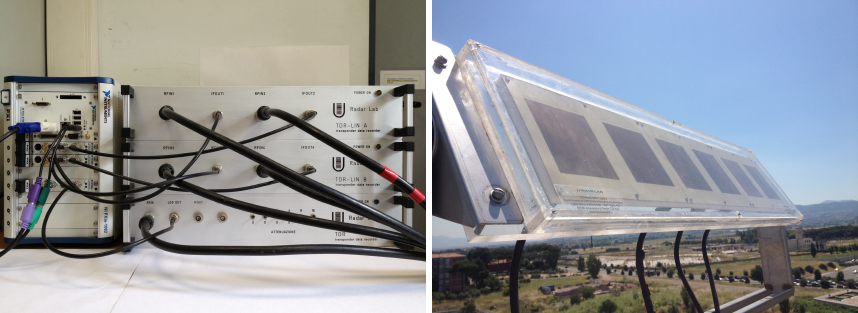
Figure 4. Transponder Data Recorder (TDR) system pictures: on the left the TDR receiver, on the right the TDR antenna.